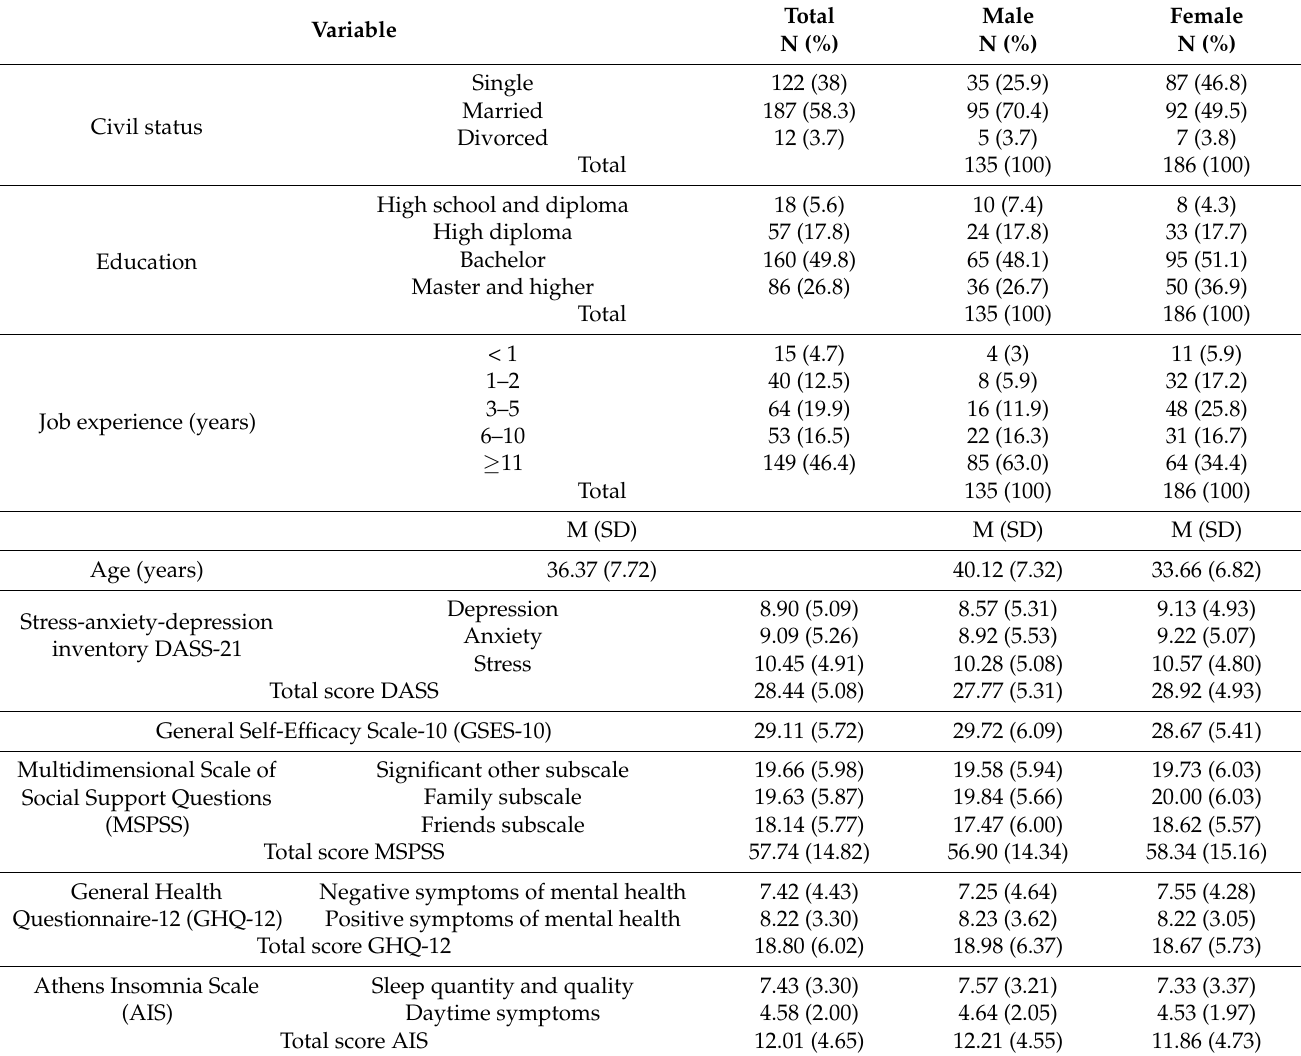
Table 1. Overview of sociodemographic and questionnaire-related descriptive